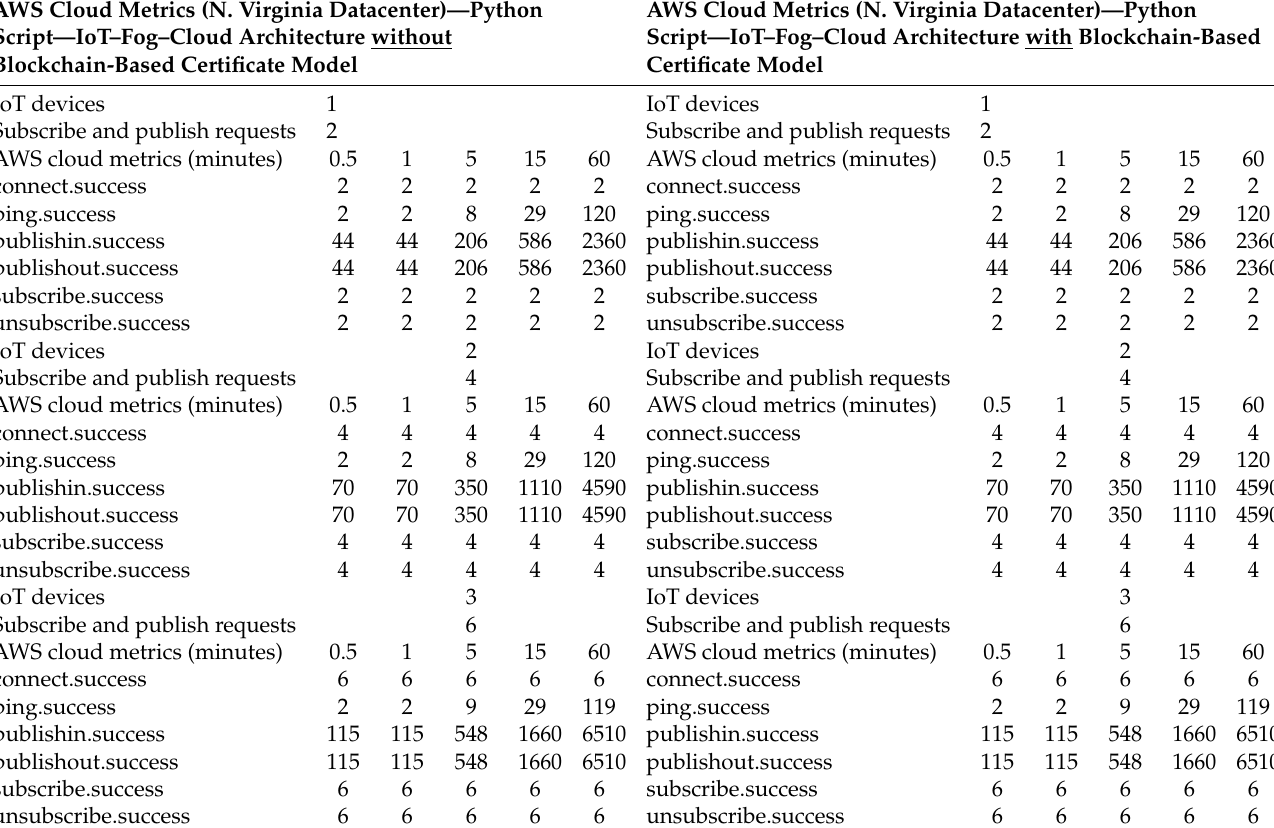
Table 3. AWS cloud metric results on N. Virginia datacenter for the IoT–Fog–Cloud architecture with the blockchain-based certificate model versus without the blockchain-based certificate